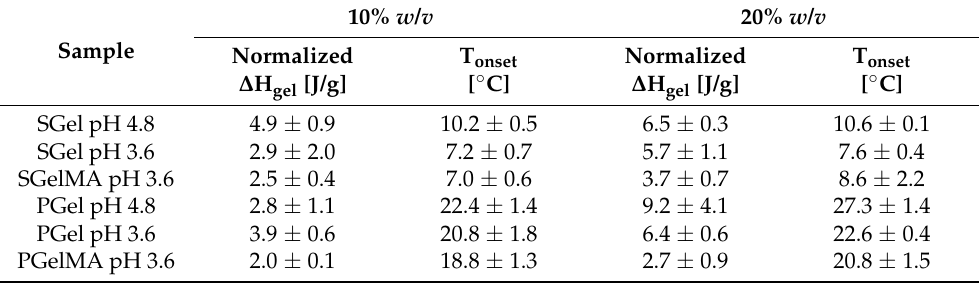
Table 4. Enthalpy ( ∆ H gel ) and gelation temperatures (T onset ) obtained for SGel and SGelMA upon cooling. Values are presented as average ± standard